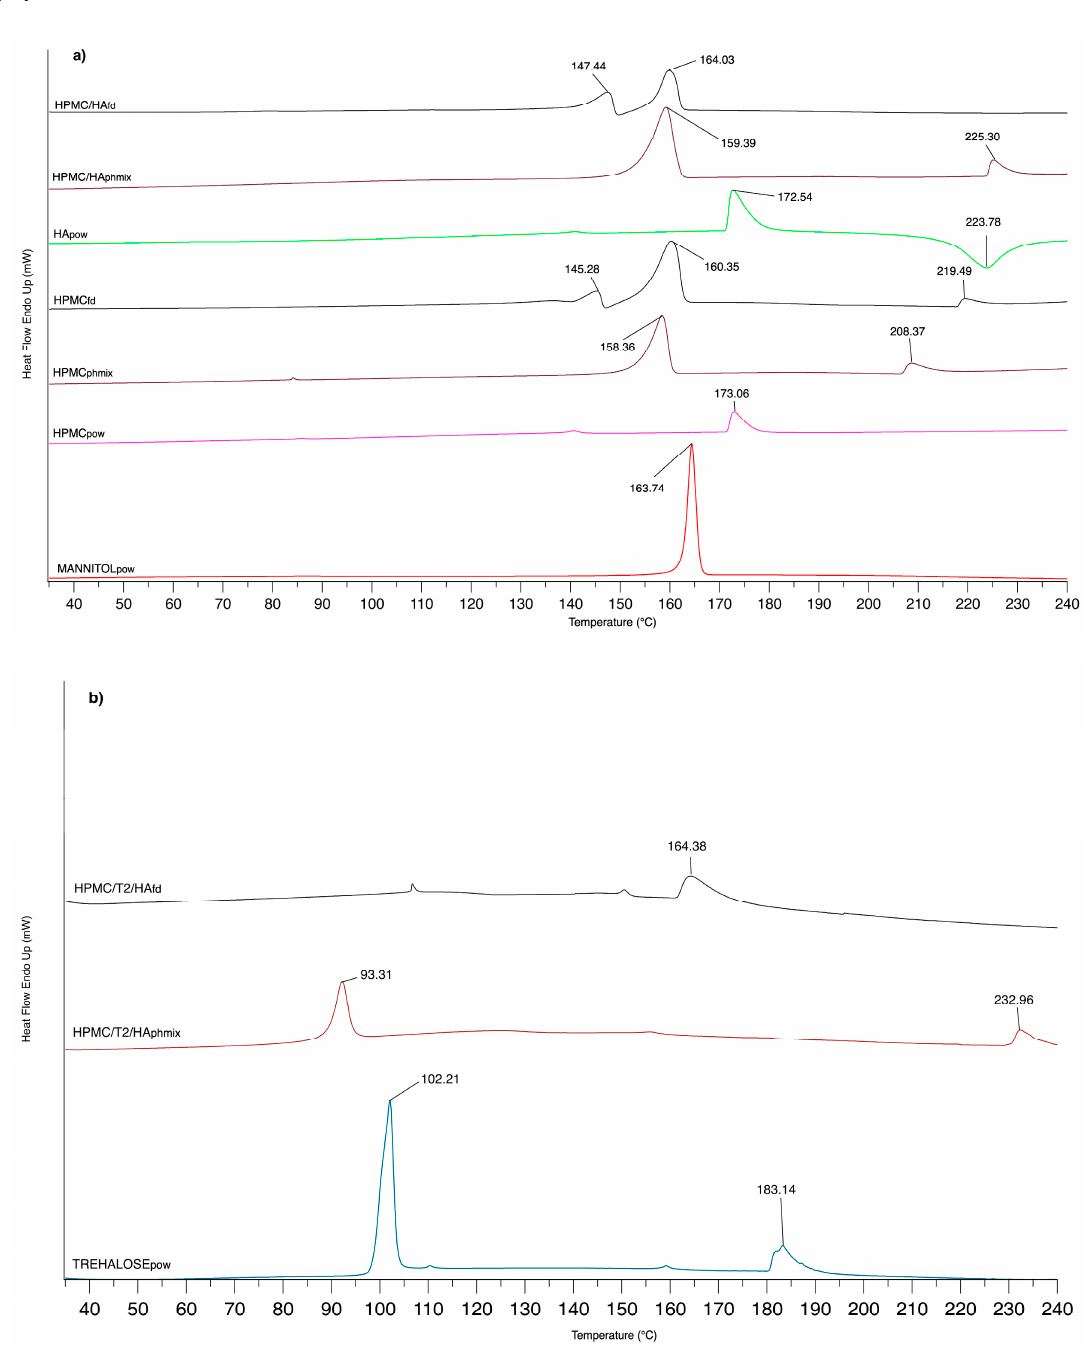
Figure 2. DSC thermograms of ( a ) mannitol, hydroxypropilcellulose (HPMC), hyaluronic acid (HA) powder ( pow ), physical mixture ( pmix ), and freeze-dried matrix ( fd ) of HPMC / HA (total polymer concentration 25 wt %; mannitol 75 wt %) and ( b ) trehalose, physical mixture ( pmix ), and freeze-dried matrix ( fd ) of HPMC / T2 / HA (total polymer concentration 25 wt %; trehalose 50 wt %; mannitol 25 wt %).